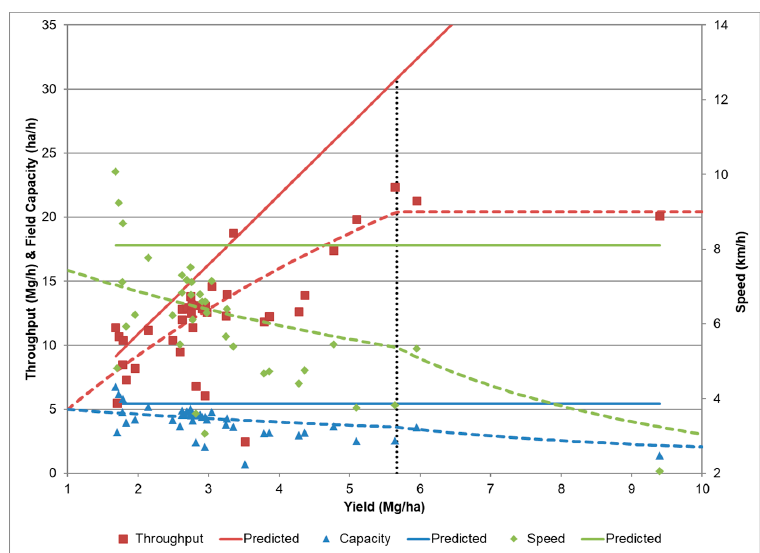
Figure 7. Effect of maximum throughput and wrap-eject time on baler performance. Productivity in Field 2, including time spent wrapping and ejecting the bale, is shown. The individual points are observations from the field data. The solid and dashed lines (green—effective speed, red—throughput, blue—achieved field capacity) are predicted [4] assuming v e = 11.0 km/h, E f = 0.74, W s = 6.7 m, t e = 32 s, and M b = 0.52 Mg.